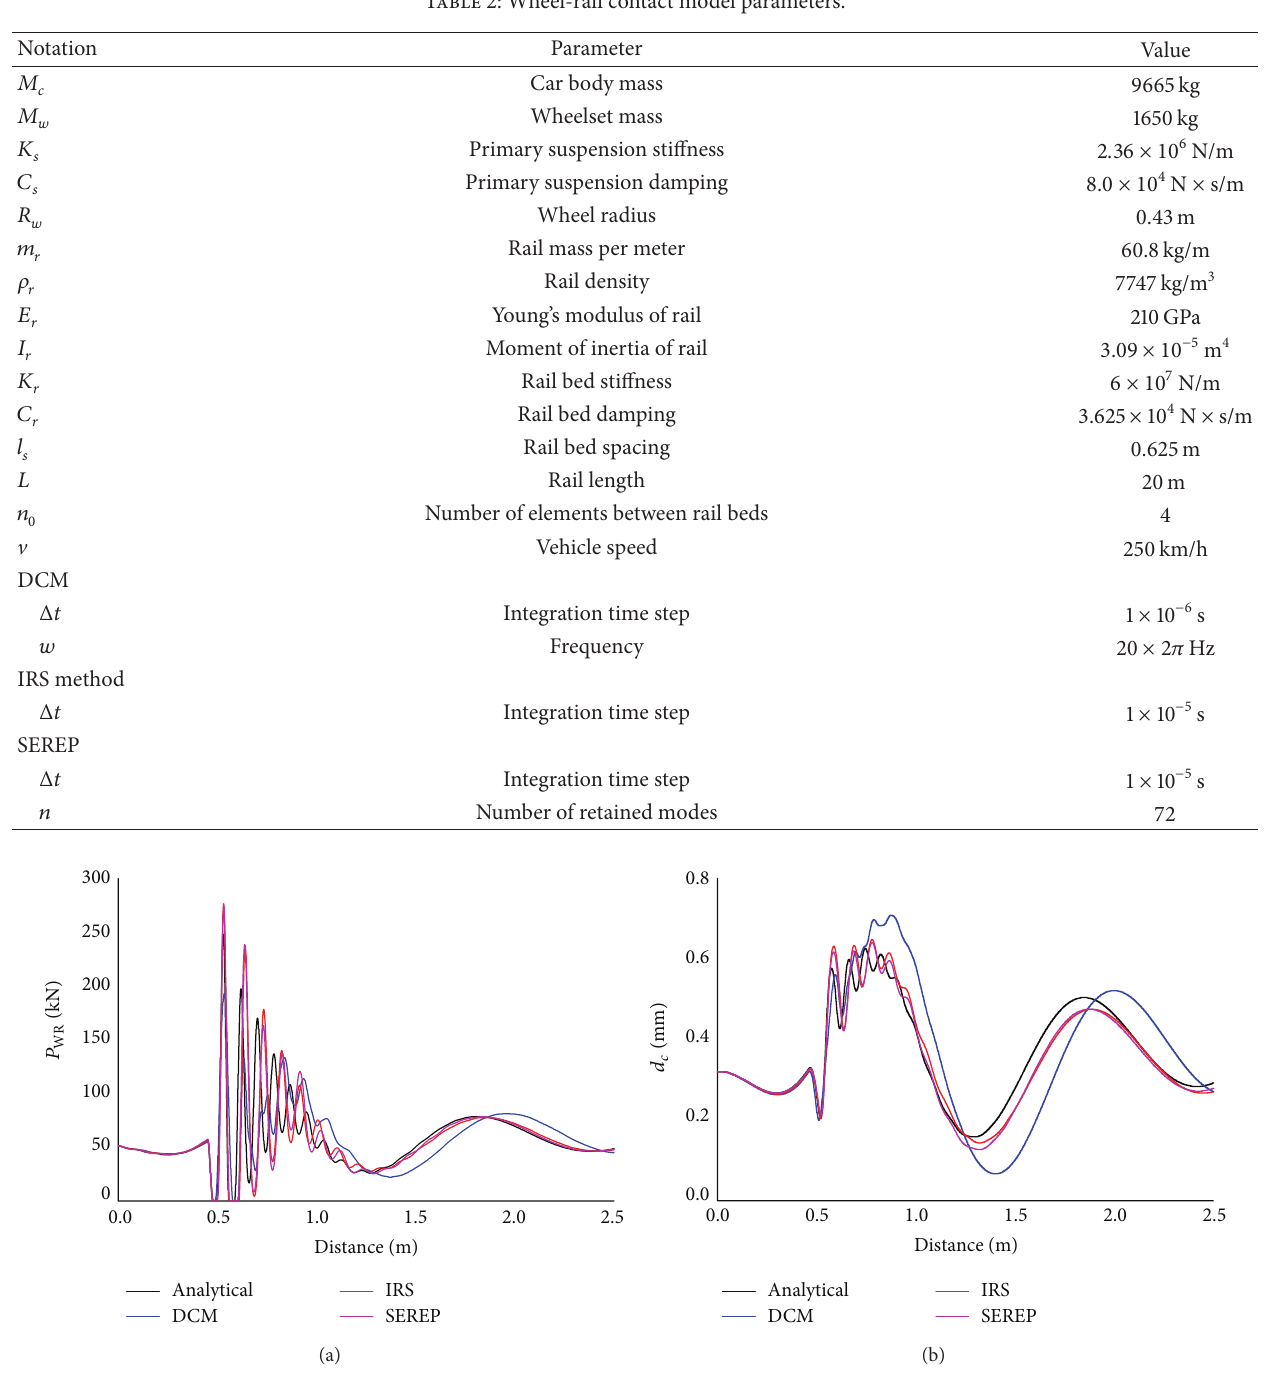
Figure 8: Comparison of (a) wheel-rail contact force 𝑃 models (DCM, IRS, and SEREP) for the analytical